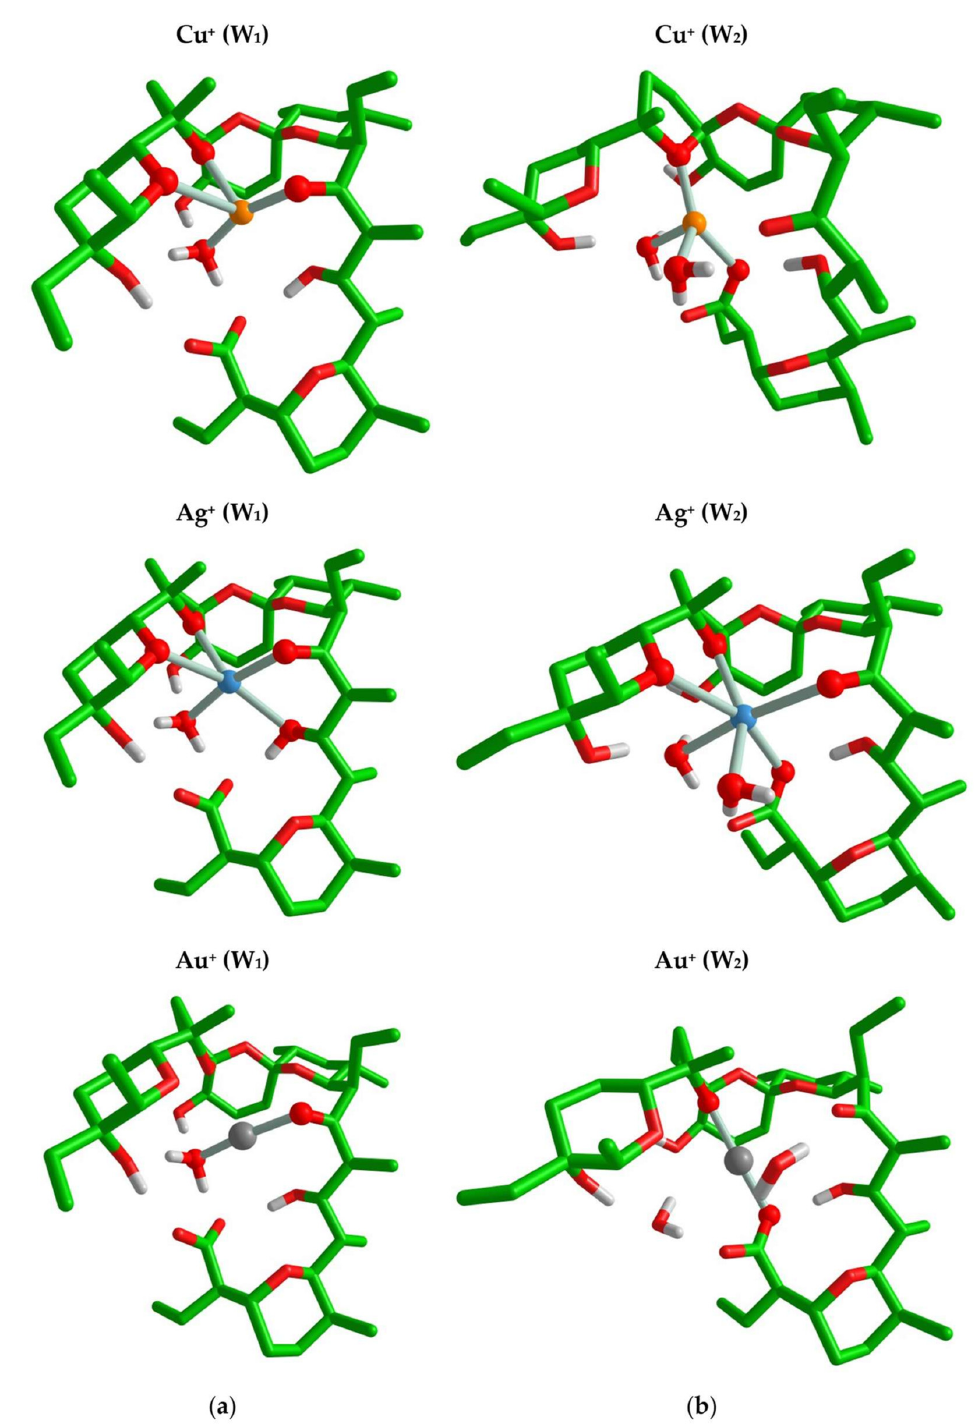
Figure 4. B3LYP/6-31+G(d,p) fully optimized structures of salinomycin complexes with Cu + , Ag + , and Au + , containing ( a ) one (W 1 ) and ( b ) two (W 2 ) water molecules. Color scheme: C—green, O—red, H—light grey, Cu—orange, Ag—light blue, Au—gray (carbon hydrogens are omitted for clarity). The affinity of salinomycin towards monovalent metal cations was evaluated modeling the competition Equation (1), where Na + , bound to the host ligand, is replaced by